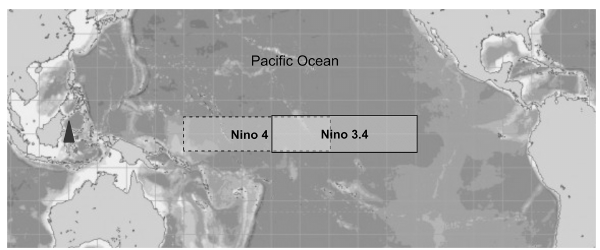
Figure 1. Geographical location of the study area (marked by black triangle) in tropical rain forest in Central Sulawesi (Indonesia) and Nino4 and Nino3.4